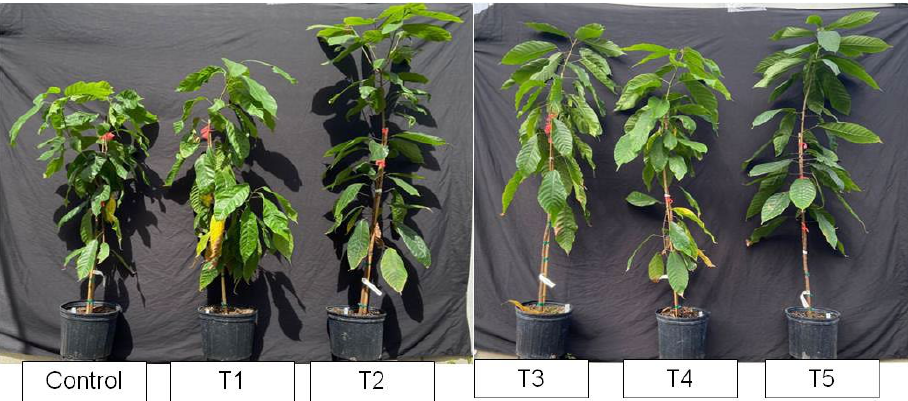
Figure 2. Cocoa plants under different fertilization rates at six months of the experiment. Control (15 g), T1 (15 g) + (15 g applied 2 times in November and March), T2 (15 g) + (15 g in November), T3 (30 g) + (15 g in November and March), T4 (30 g) + (15 g November) and T5 (45 g) + (15 g in November and March).